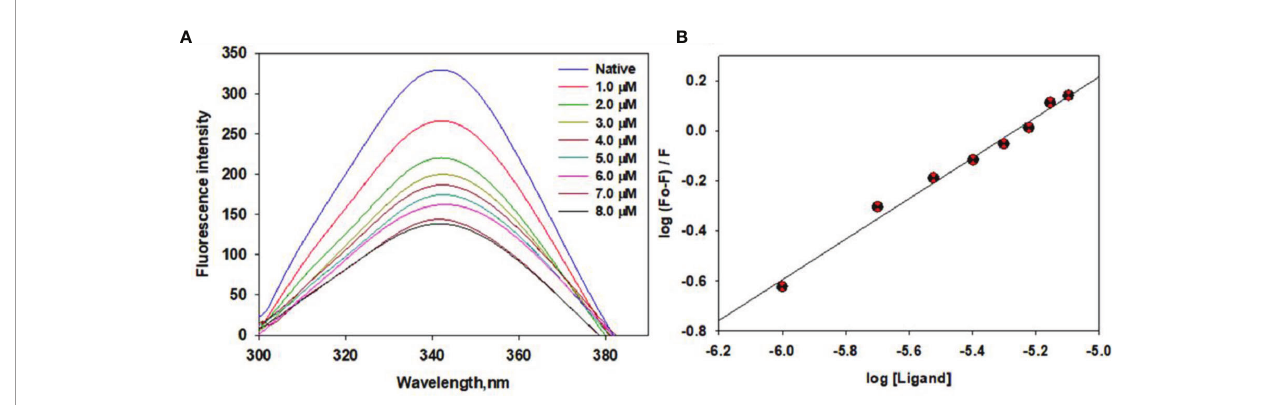
FIGURE 7 | Fluorescence binding studies of selonsertib with CDK6. (A) Fluorescence emission spectra of CDK6 with increasing concentrations of selonsertib (1 – 8 m M). (B) Modi fi ed Stern – Volmer plots to estimate the binding af fi nity of selonsertib with the